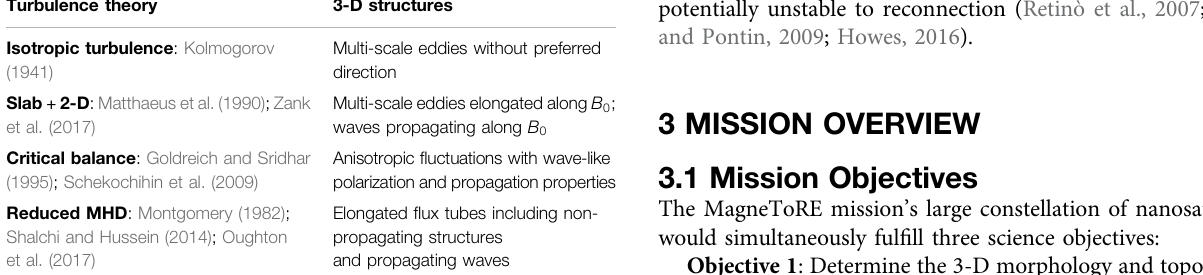
TABLE 1 | Comparison of prominent theories of solar-wind turbulence. Turbulence theory 3-D structures Isotropic turbulence : Kolmogorov (1941)